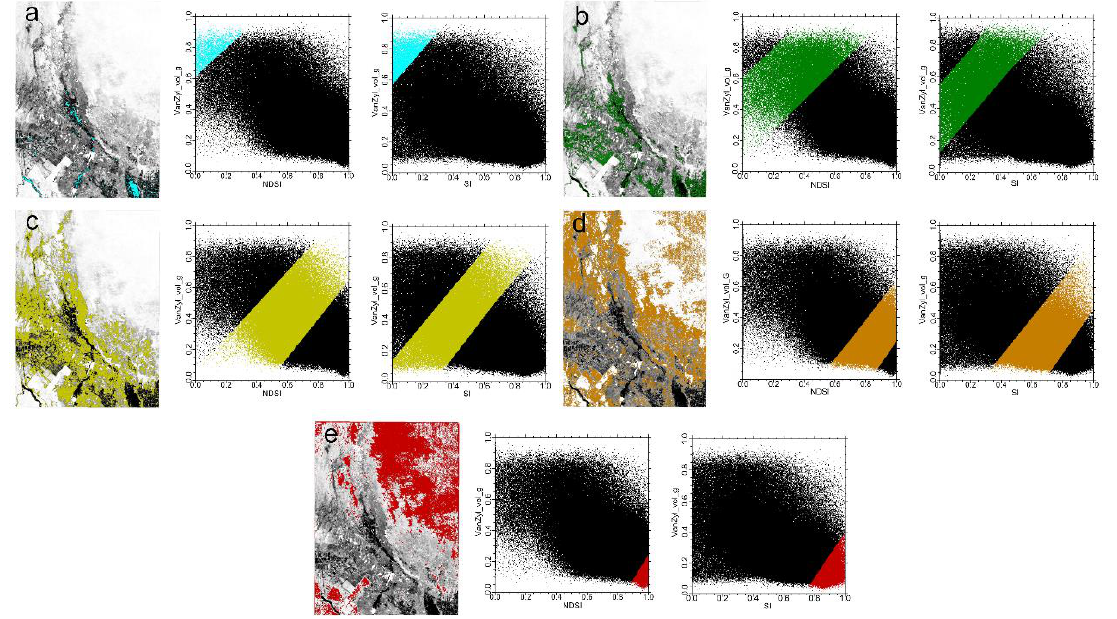
Figure 9. The soil salinity content in the image and NDSI-Van_vol_g and SI-Van_vol_g spaces: ( a ) water; ( b ) plant cover; ( c ) mildly saline soil; ( d ) moderately saline soil; ( e ) heavily saline soil.